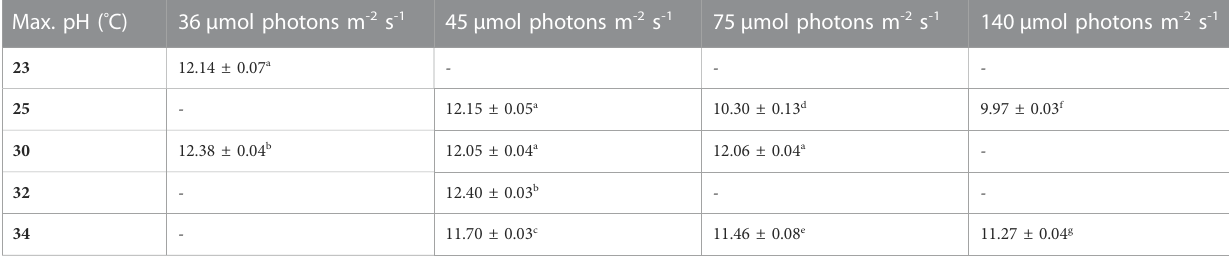
TABLE 5 Maximum pH values under different conditions, the values are shown as mean ± SD of four to eight